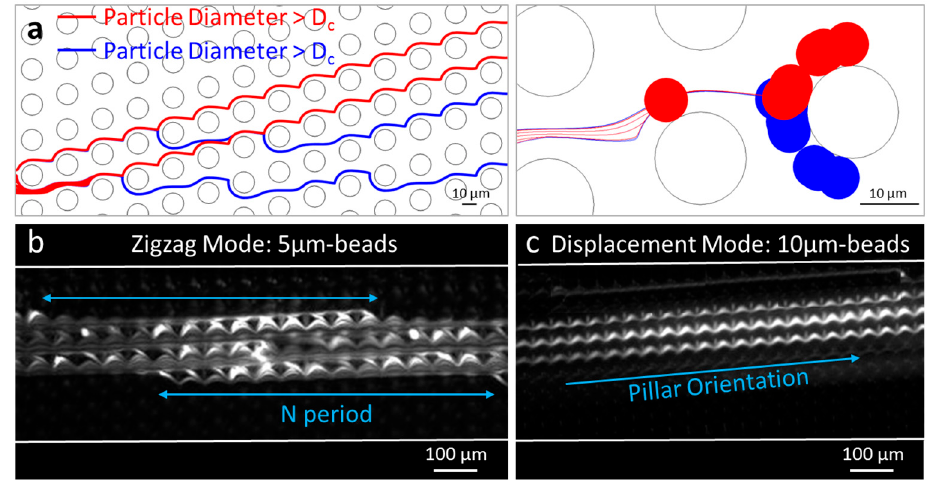
Figure 1. ( a ) Finite element modeling of the DLD separation; Epifluorescence microscopy images of the trajectory of 5 µm ( b ) and 10 µm ( c ) polystyrene fluorescent beads in a DLD device of triangular pillars (inter-pillar spacing = 20 µm and array period =